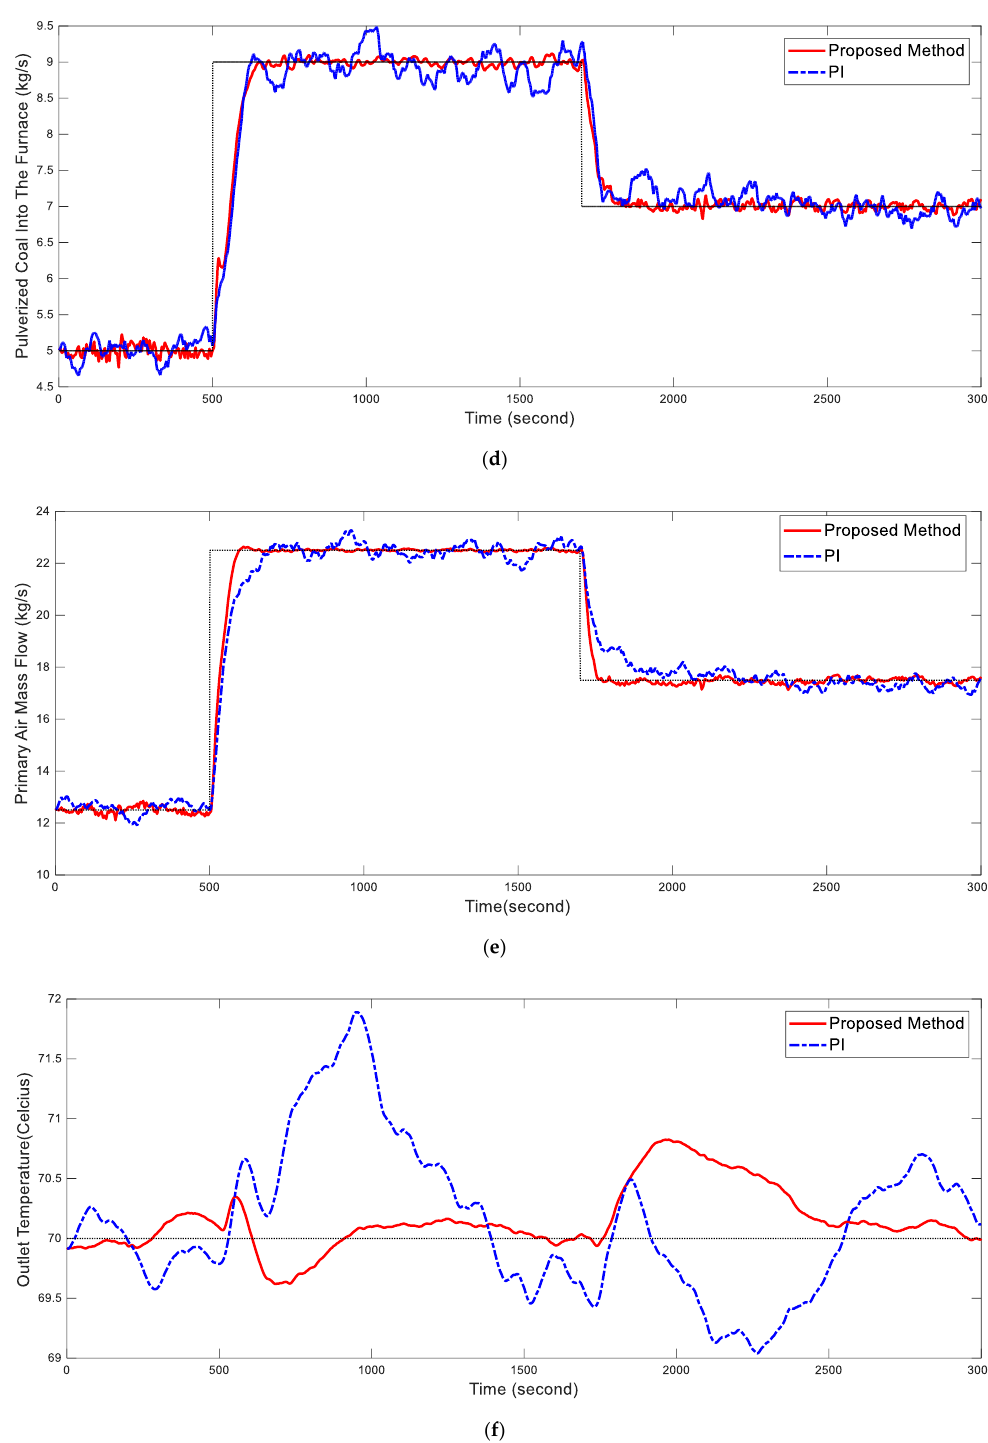
Figure 12. Proposed and PID control method performances for ( a – c ) control inputs, and ( d – f ) controlled outputs. ( a ) Raw coal flow; ( b ) Hot air baffle opening; ( c ) Cold air baffle opening; ( d ) Pulverized coal into the furnace; ( e ) Primary air mass flow; ( f ) Outlet temperature.